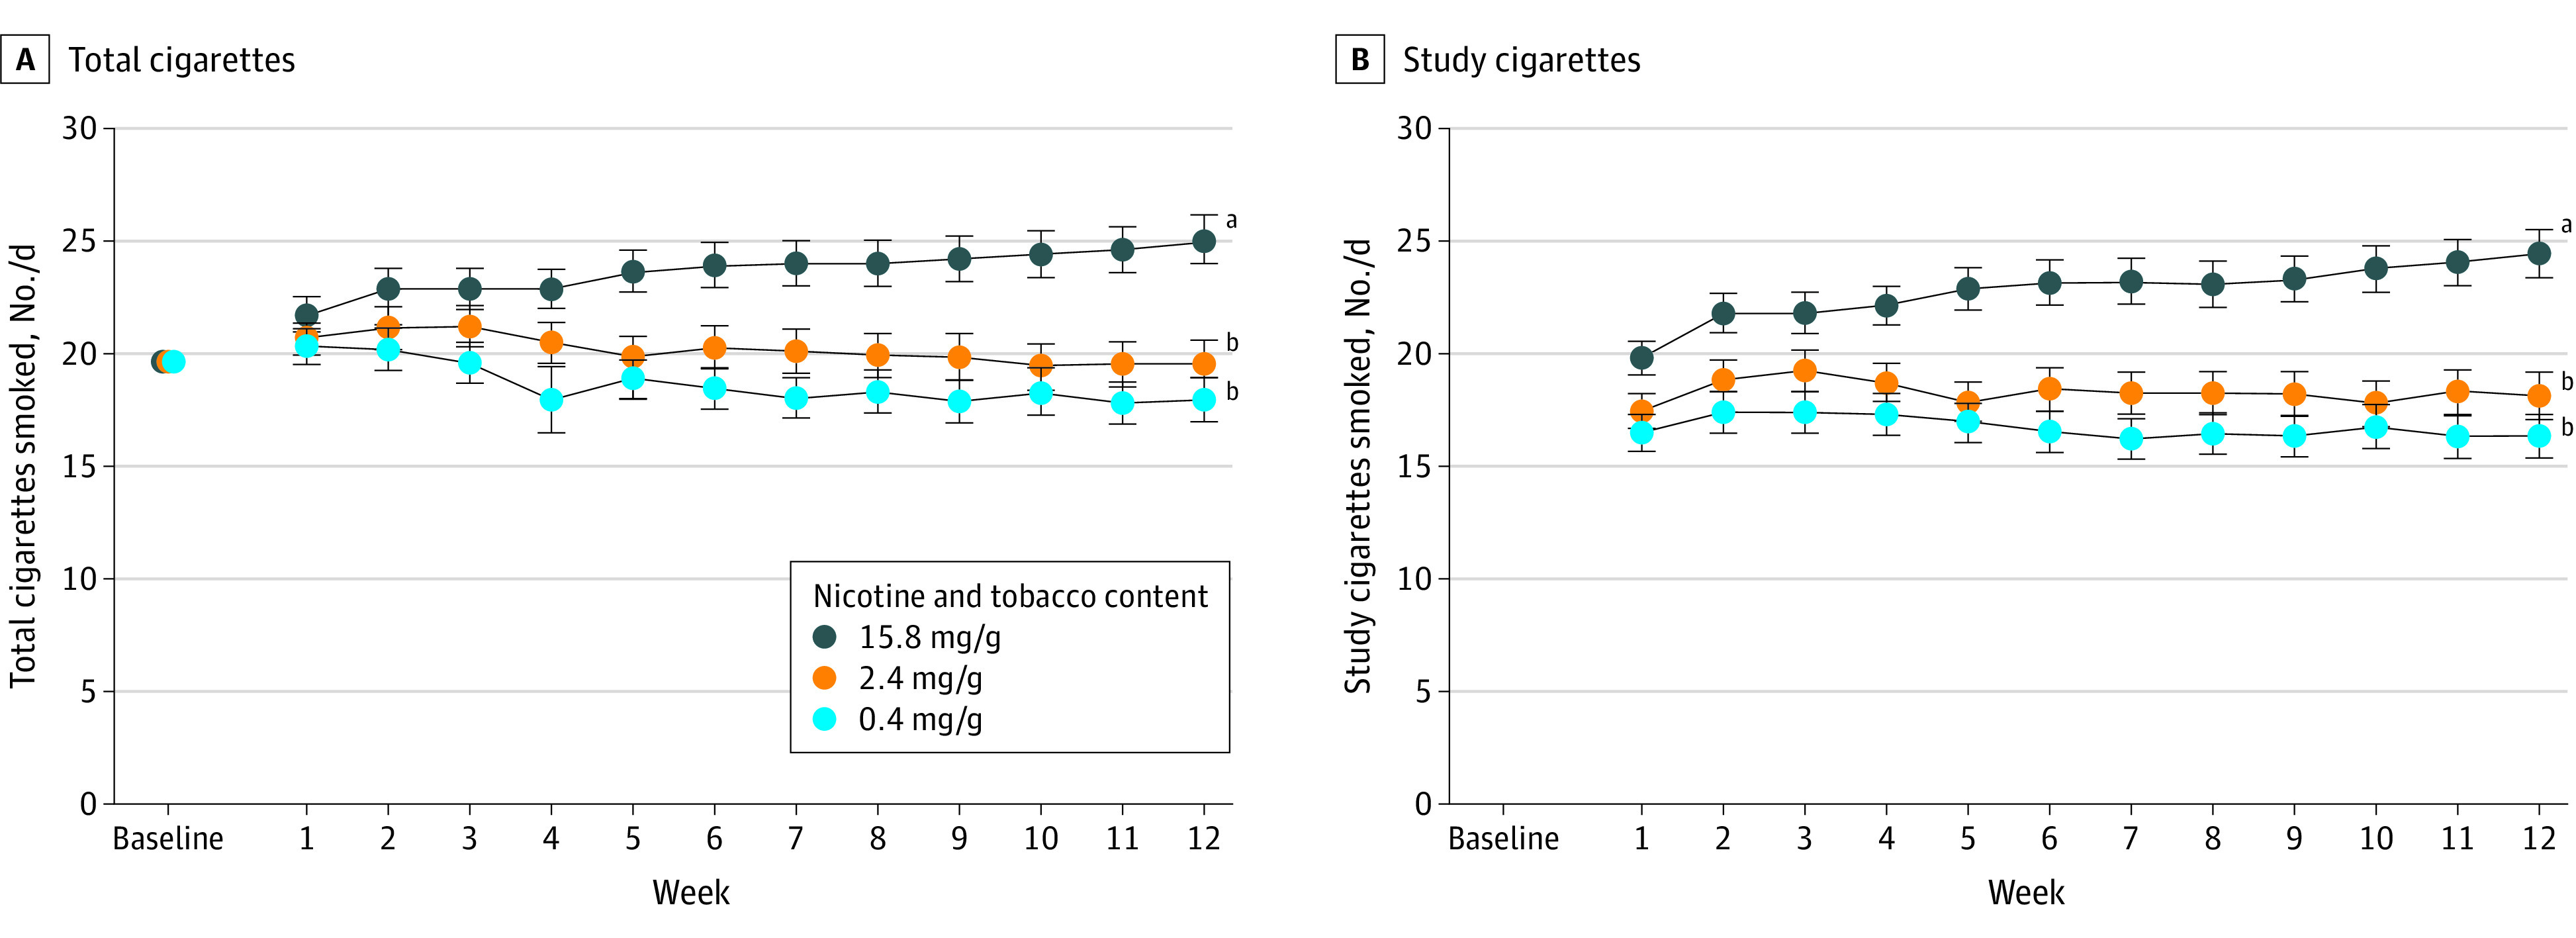
Number of Total and Study Cigarettes Smoked per Day According to Nicotine ContentData points are arithmetic means collapsed across participants and populations; error bars indicate SEM. Data not sharing a superscript letter differed significantly in post hoc testing and in slope of linear trends.